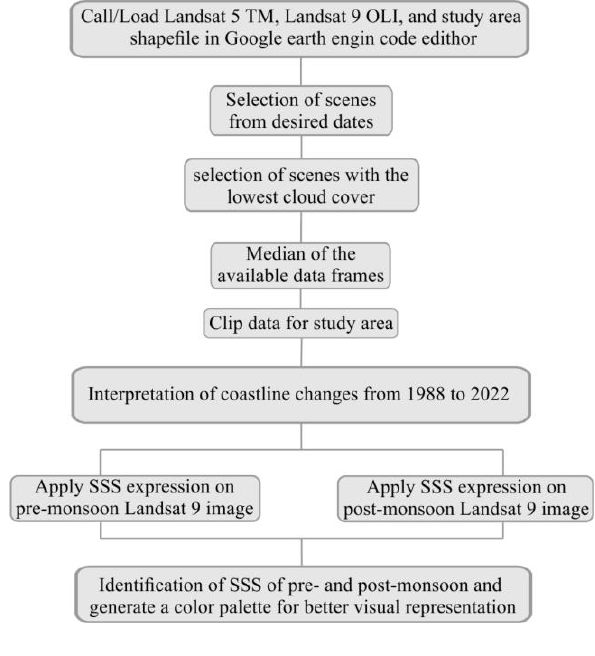
Figure 3 . Methodology flow